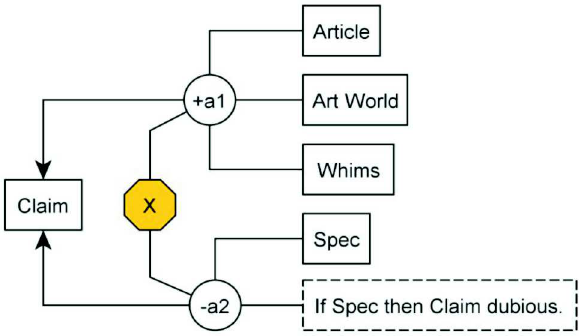
Figure 2. Diagram of Landscape